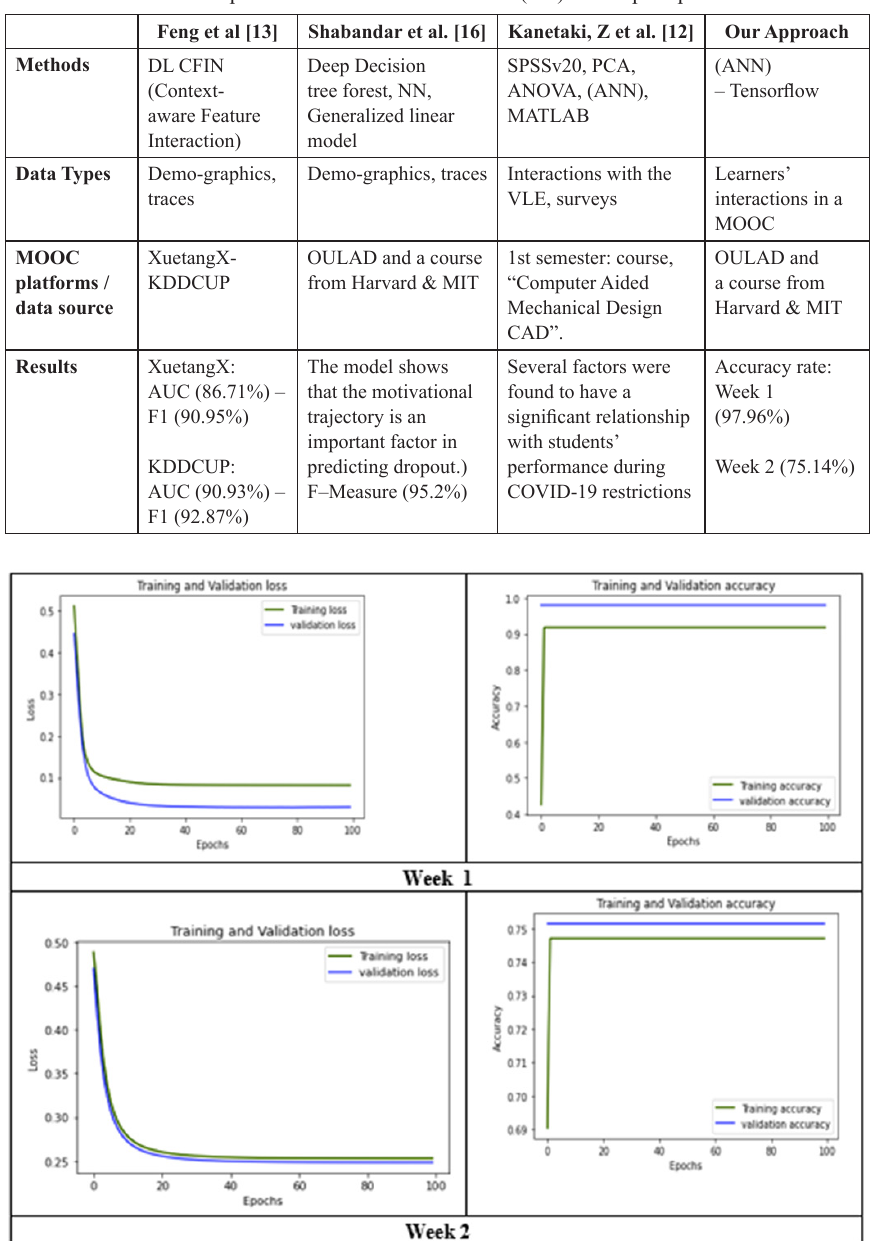
Table 8. Comparison of the main AI methods (DL) for dropout prediction